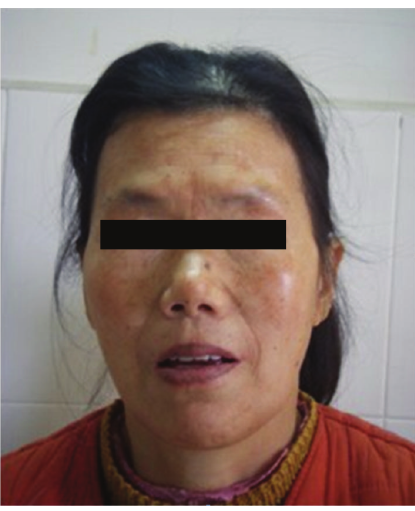
Figure 1: The eyebrows fall o ff